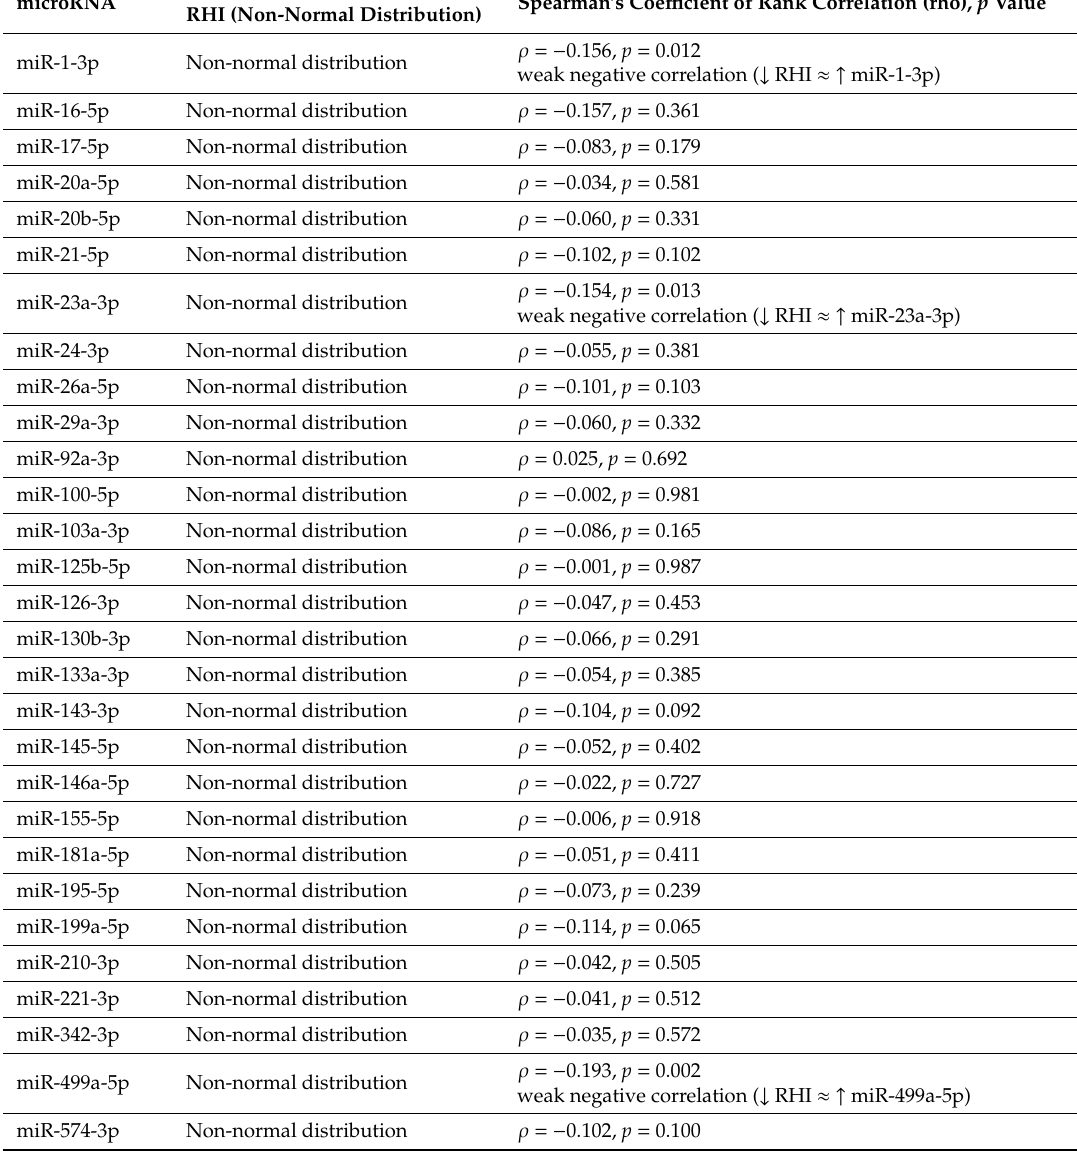
Table 7. Association between the vascular endothelial function (RHI values) and the expression of cardiovascular and cerebrovascular disease associated microRNAs in whole peripheral blood of young and middle-aged women_ overview (Spearman’s coe ffi cient of rank